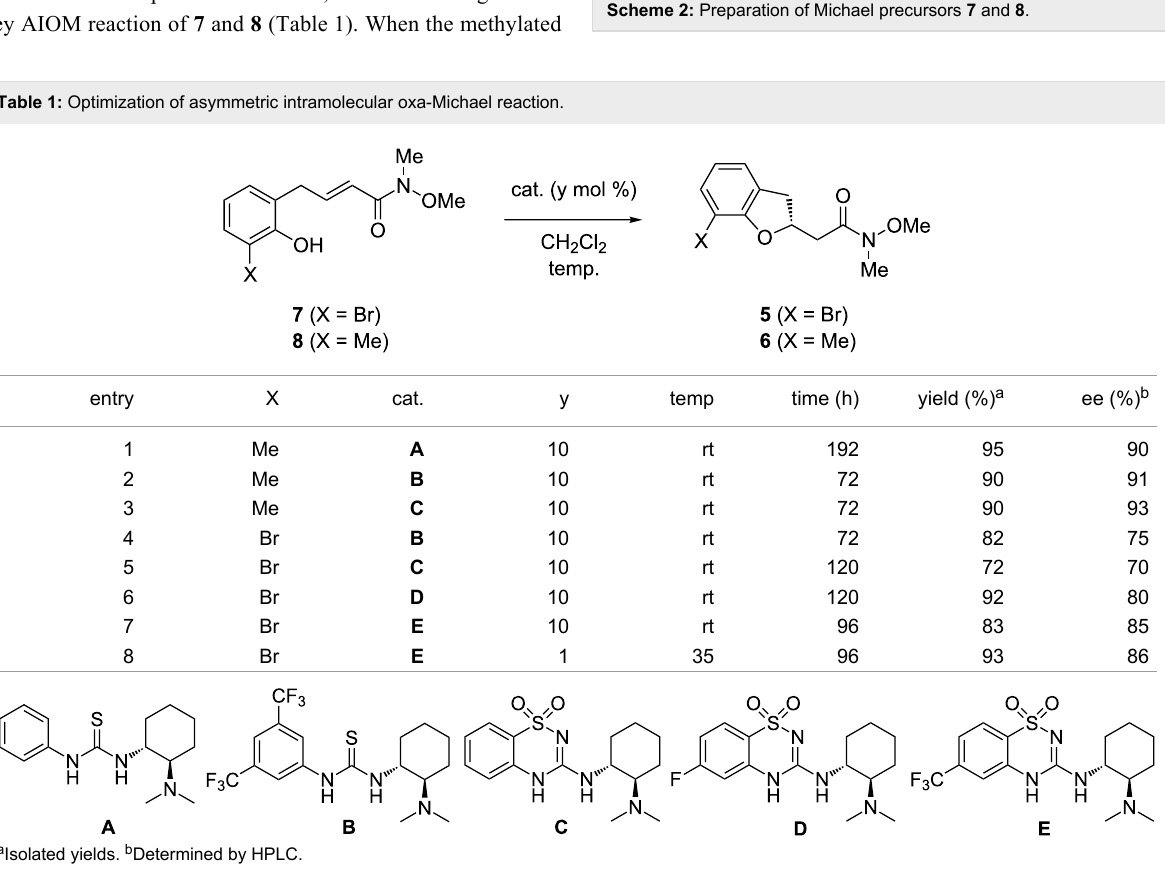
Scheme 2: Preparation of Michael precursors 7 and 8